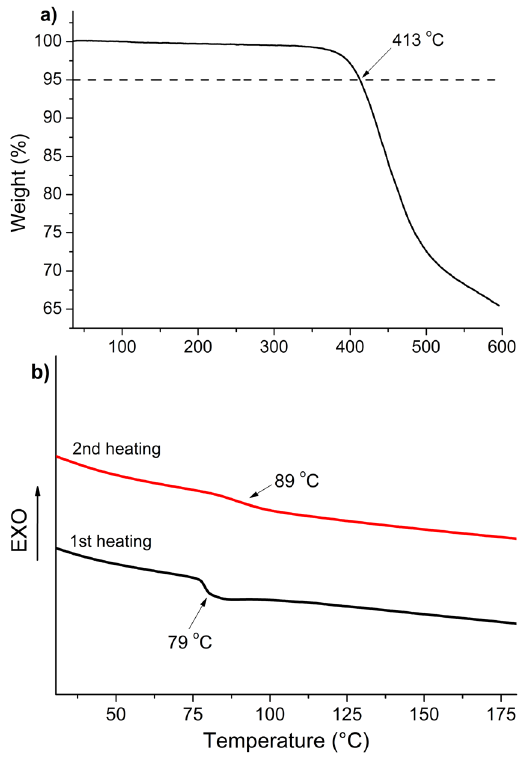
Figure 3. Thermogravimetric ( a ) and differential scanning calorimetry ( b ) heating curves of HTM4 (heating rate 10 K min − 1 , N 2 atmosphere).